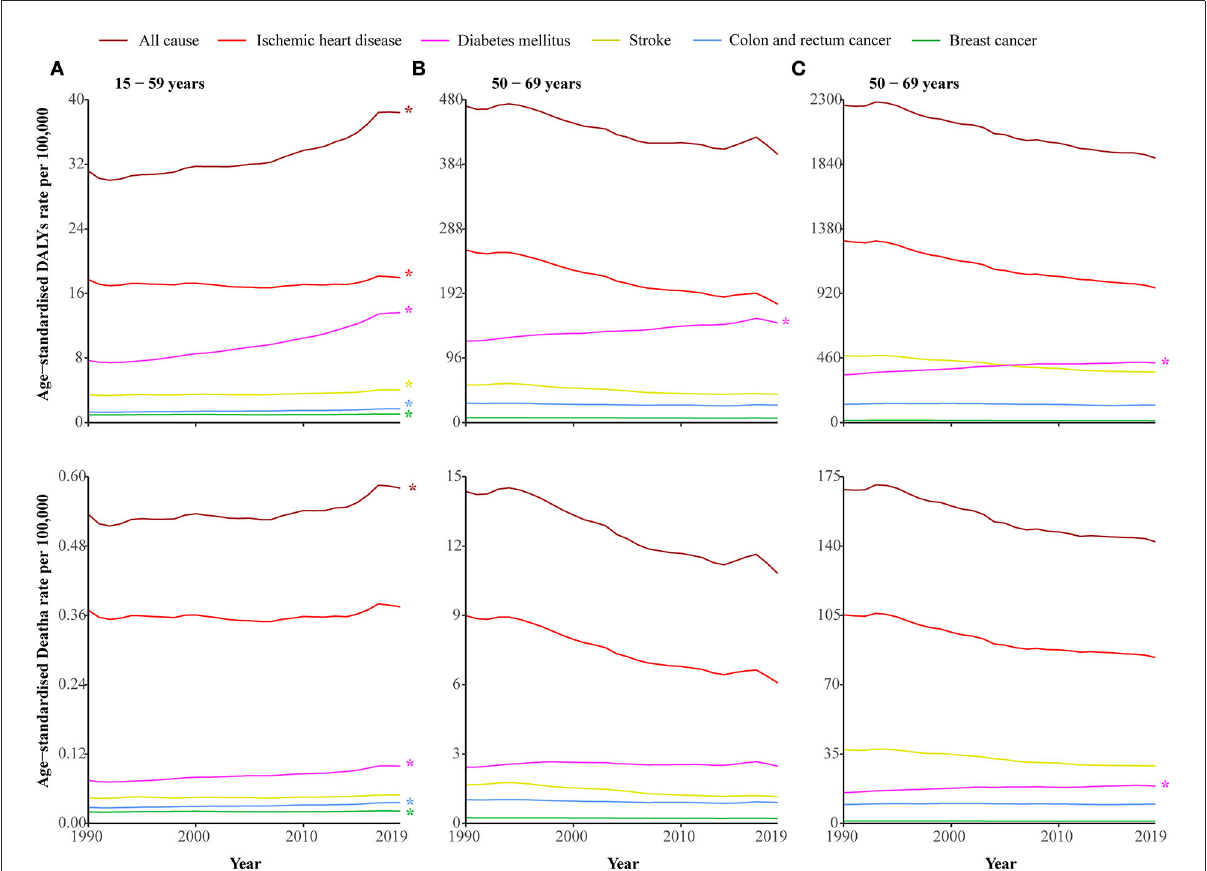
FIGURE3 DALYs and death rates of disease attributable to low physical activity amongst the three age groups from 1990 to 2019. (A) 15–49 years. (B) 50–69 years. (C) 70 + years. * represents statistically significant.